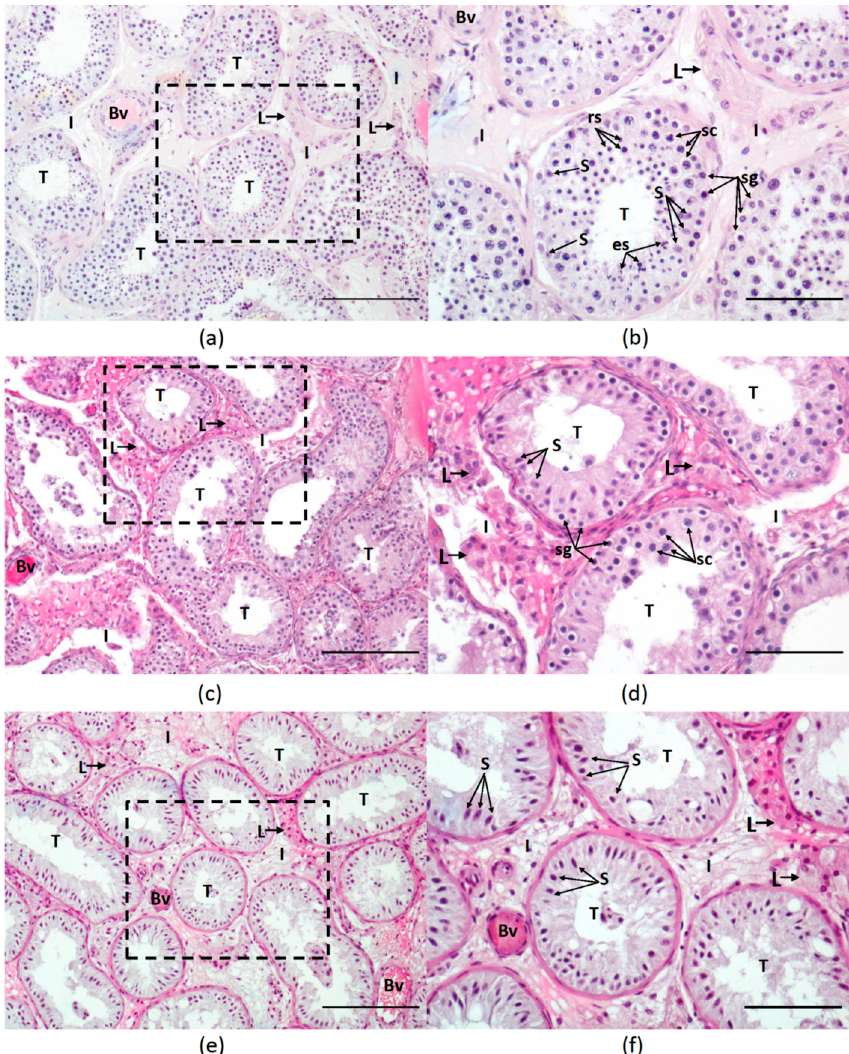
Figure 1. ( a ) Representative microphotograph of hematoxylin-eosin-stained histological sections of testicular biopsy from men with obstructive azoospermia. Seminiferous tubules (T) display a normal diameter and are lined with the seminiferous epithelium with complete spermatogenesis; between tubules, an interstitial space (I) is present with Leydig cell clusters (L) and blood vessels (Bv); ( b ) Higher magnification of the testicular area surrounded by the dash lines in ( a ); in sem- iniferous tubules, Sertoli cells characterized by large irregular nuclei with distinct nucleoli and extensive cytoplasmic processes extending from the basement membrane to the lumen of the tubule are present (S—Sertoli cell nucleus); Sertoli cell cytoplasm surrounds different types of germ